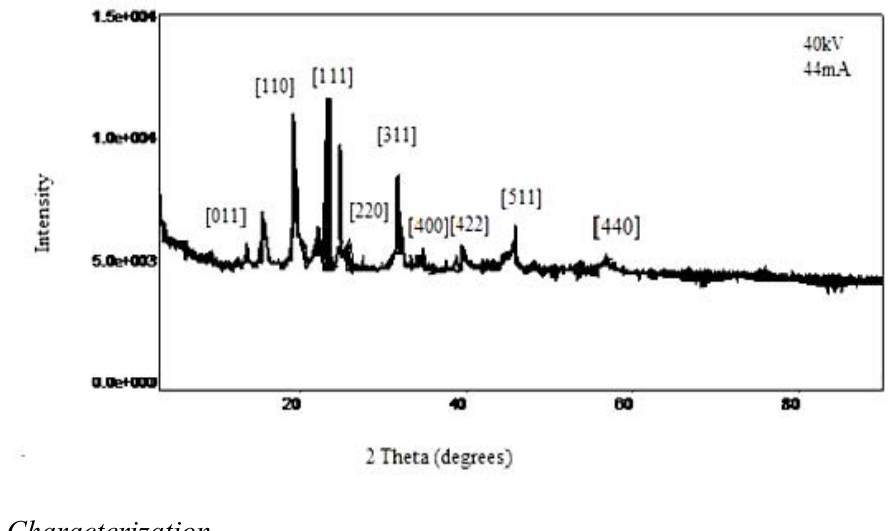
Figure 5. Zero-field cooled (circle symbols) and field cooled (square symbols) magnetization vs . temperature for polymorphous Fe measured with a dc field of 100 Oe. τ